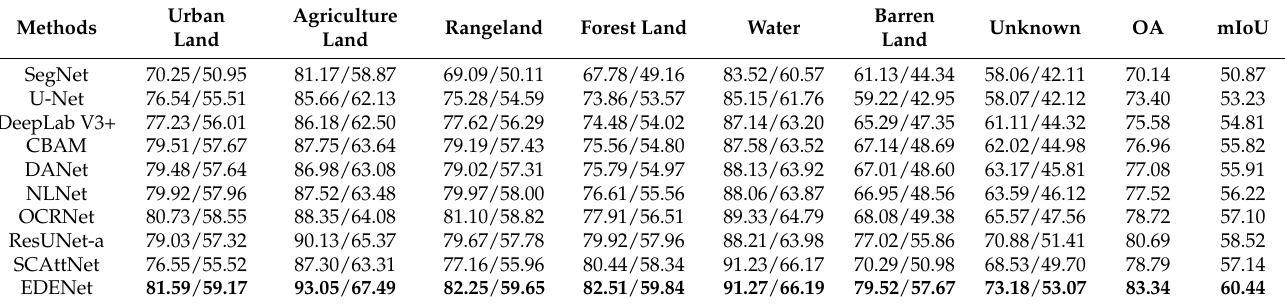
Table 6. Results on DeepGlobe dataset. Accuracy of each category is presented in the OA/IoU form.